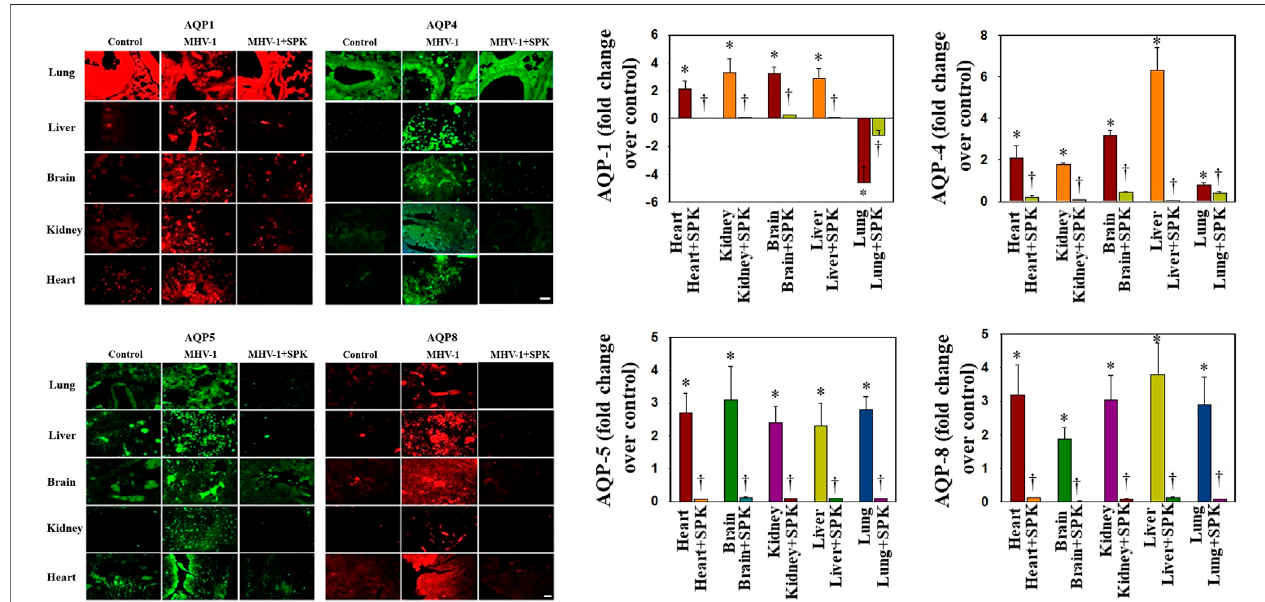
FIGURE 6 | Altered AQP levels were identi fi ed in various organs post-MHV-1 inoculation. While increased AQPs 1 and 4 have been identi fi ed in various organs, AQP1levels weredecreased in lungs post-MHV-1.Further, treatment ofMHV-1 inoculated mice withSPK (5 mg/kg) reversed these changes. A widespread increasein AQPs5and 8wasobservedinmice post-MHV-1 inoculation,andtreatmentofMHV-1inoculated micewithSPK(5 mg/kg)reversedthesechanges.Scalebar=25 μ m. Quantitation of AQPs 1, 4, 5, and 8 immuno fl uorescence images. ANOVA, n = 5 (Control), 16 (MHV-1) and 7 (MHV-1 + SPK). * p < 0.05 versus control; † p < 0.05 verses MHV-1 infected mice. Error bars represent mean ±